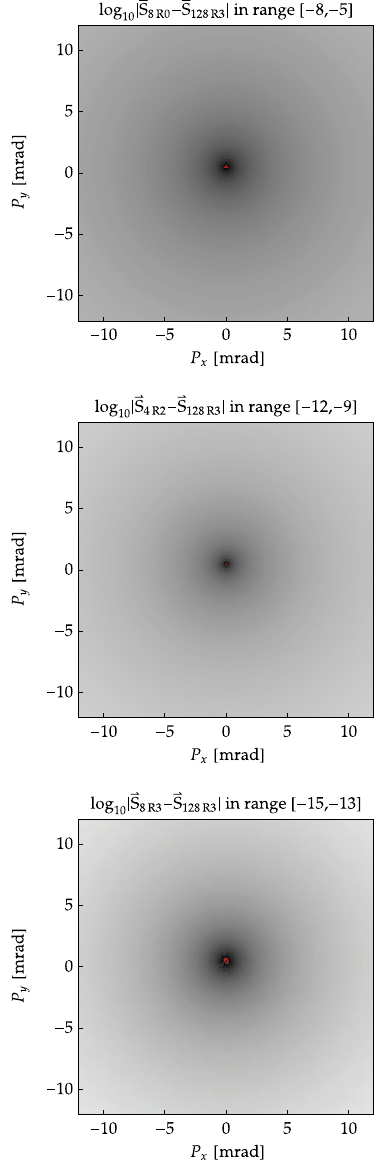
(lower).FIG. 13. Absolute error in the computed spin across a